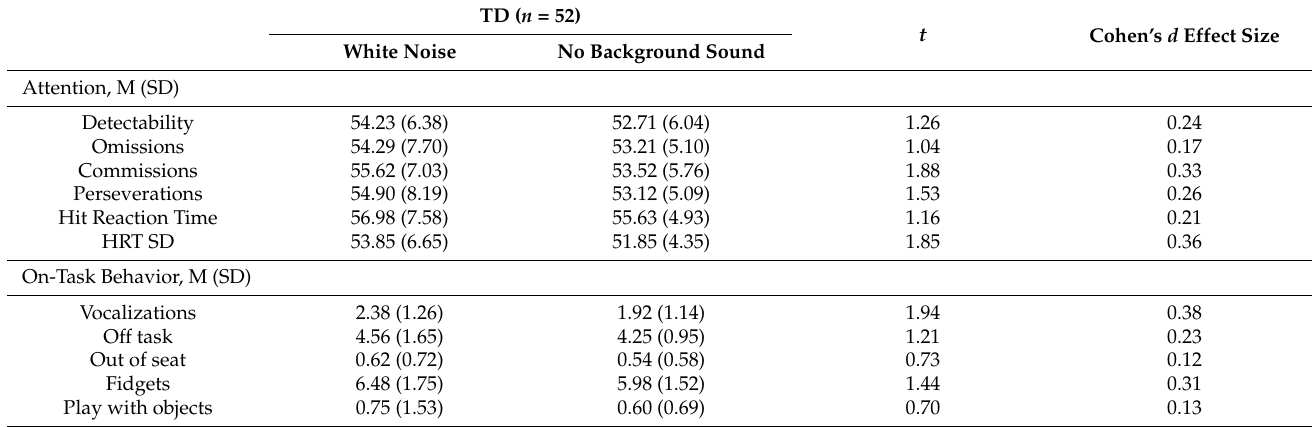
Table 5. Comparison of TD preschoolers’ performance between two background sound